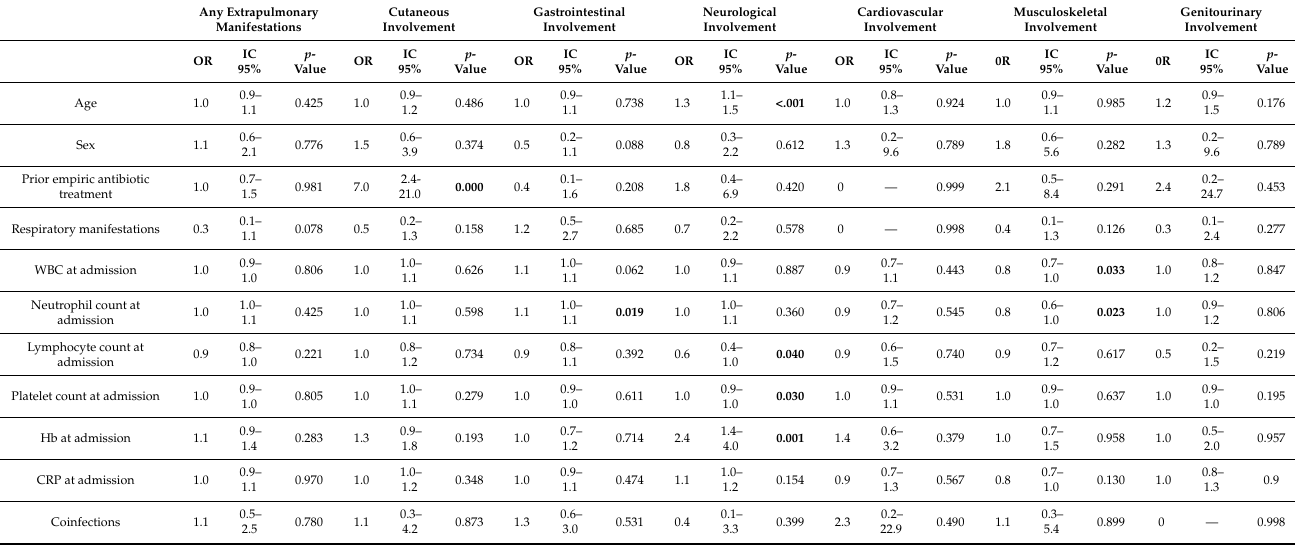
Table 3. Univariate analysis of risk factors associated with extrapulmonary